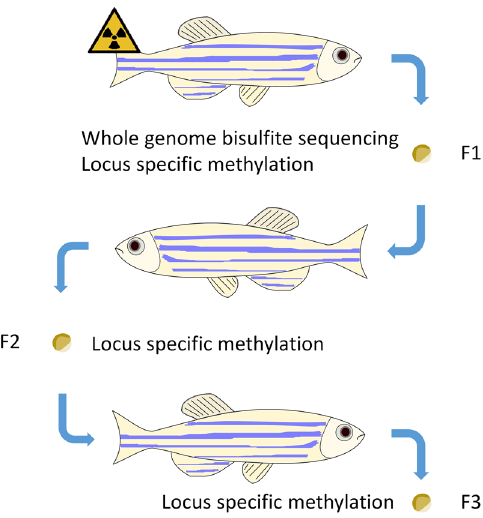
Figure 1. Experimental set-up. Family inbreeding was performed of control and exposed adults (8.7 mGy/h), embryos were harvested 5.5 hours post fertilization for DNA methylation analysis at every